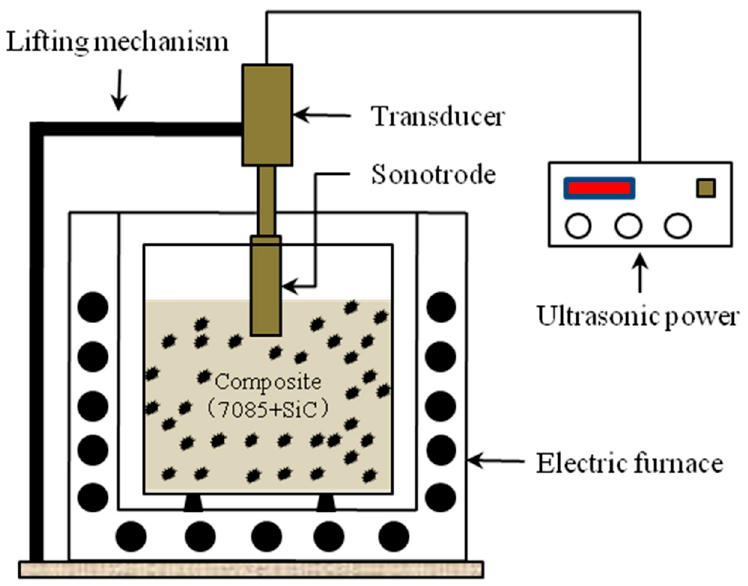
Figure 1. Diagram of ultrasonic casting experimental apparatus.